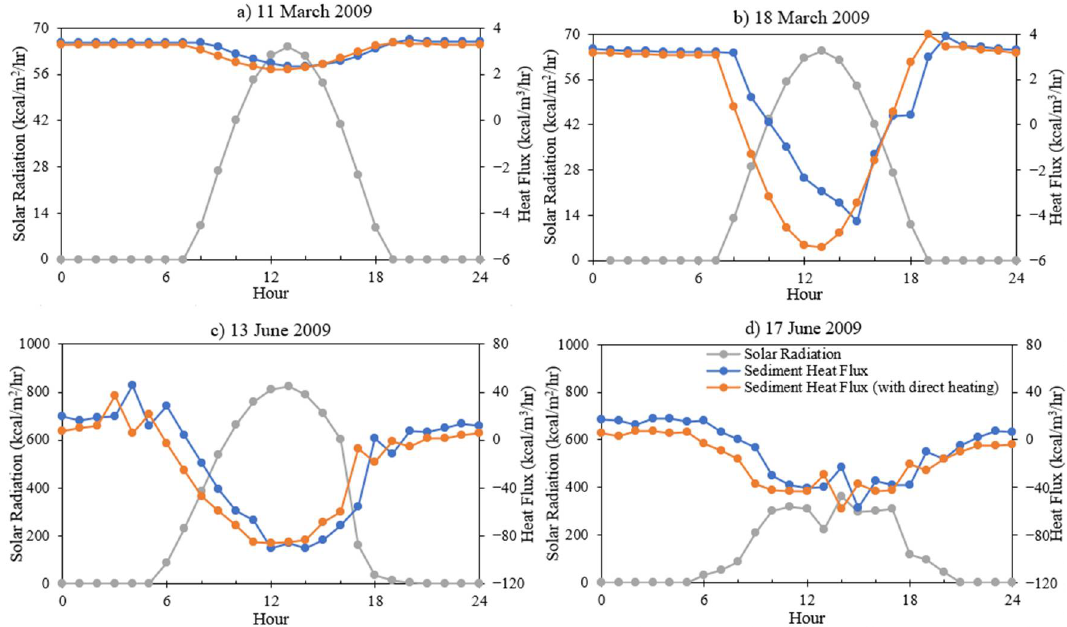
Figure 8. Comparison of heat flux calculated by the modified and previous sediment models on an hourly basis on ( a ) day with ice and snow cover, ( b ) day with ice cover but no snow cover, ( c ) high solar radiation day in June, ( d ) low solar radiation day in June. The y-axis scales on ( a , b ) are different from on ( c , d ).